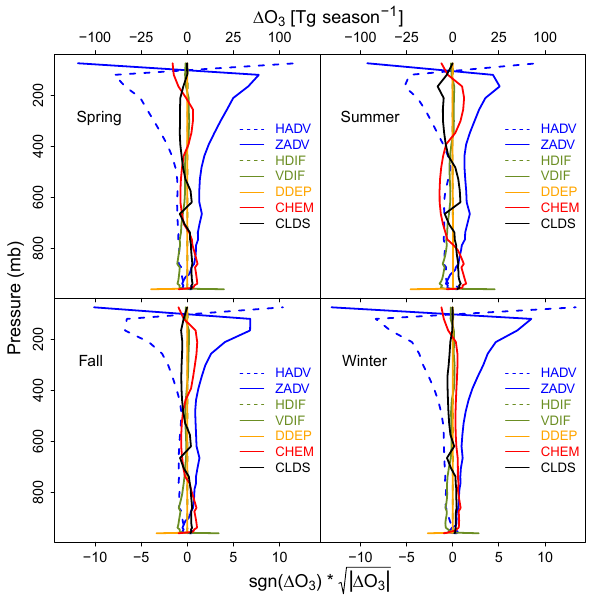
Figure 4. Profiles of BASE seasonal total ozone column mass changes (cid:49) O 3 for each CMAQ model layer due to the effects of horizontal advection (HADV), vertical advection (ZADV), hori- zontal diffusion (HDIF), vertical diffusion (VDIF), dry deposition (DDEP), chemistry (CHEM), and cloud processes including vertical mixing by convective clouds (CLDS). The values are summed over the entire modeling domain and represent the net change in ozone mass due to a given process in a given model layer and